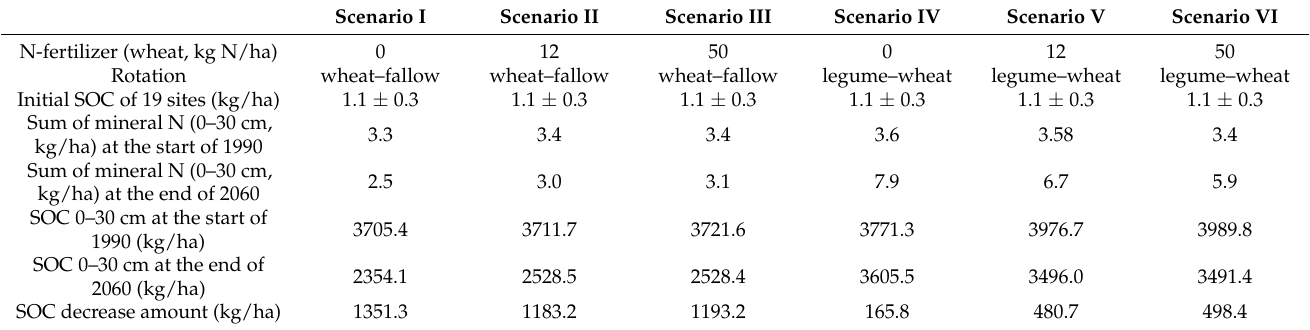
Table 4. Changes of soil characteristics in six scenario simulations for